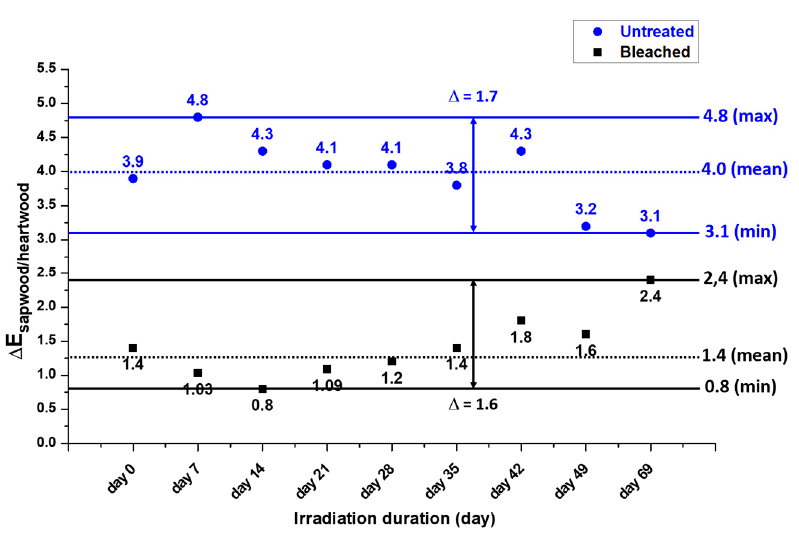
Figure 12. Δ E evolution of untreated and bleached samples during UV irradiation ageing. Figure 12. ∆ E evolution of untreated and bleached samples during UV irradiation